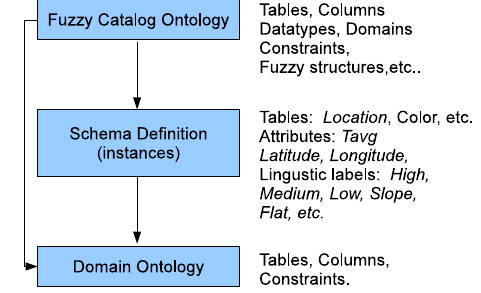
Fig. 3. Ontologies involved in the definition